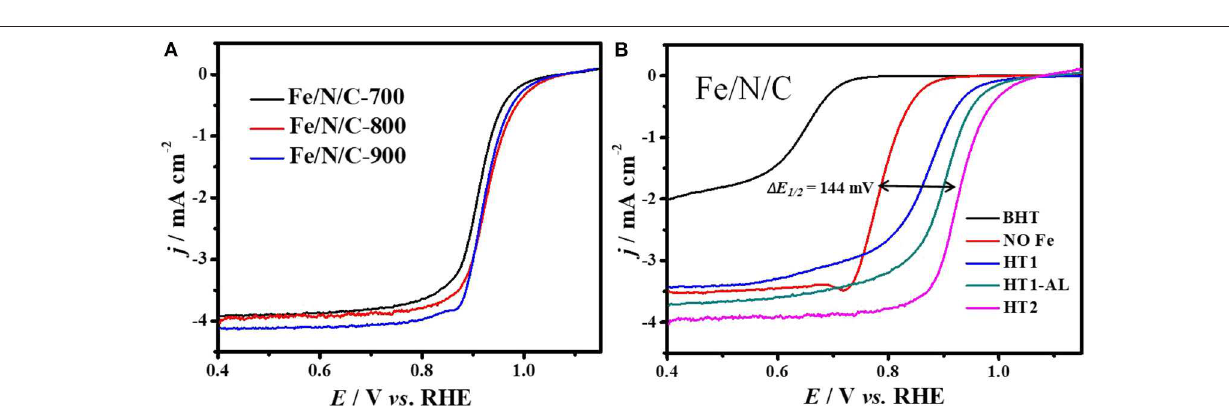
respectively. Both the pyridinic N1 and graphitic N3 may take part in the ORR process in alkaline solution (Wen et al.,